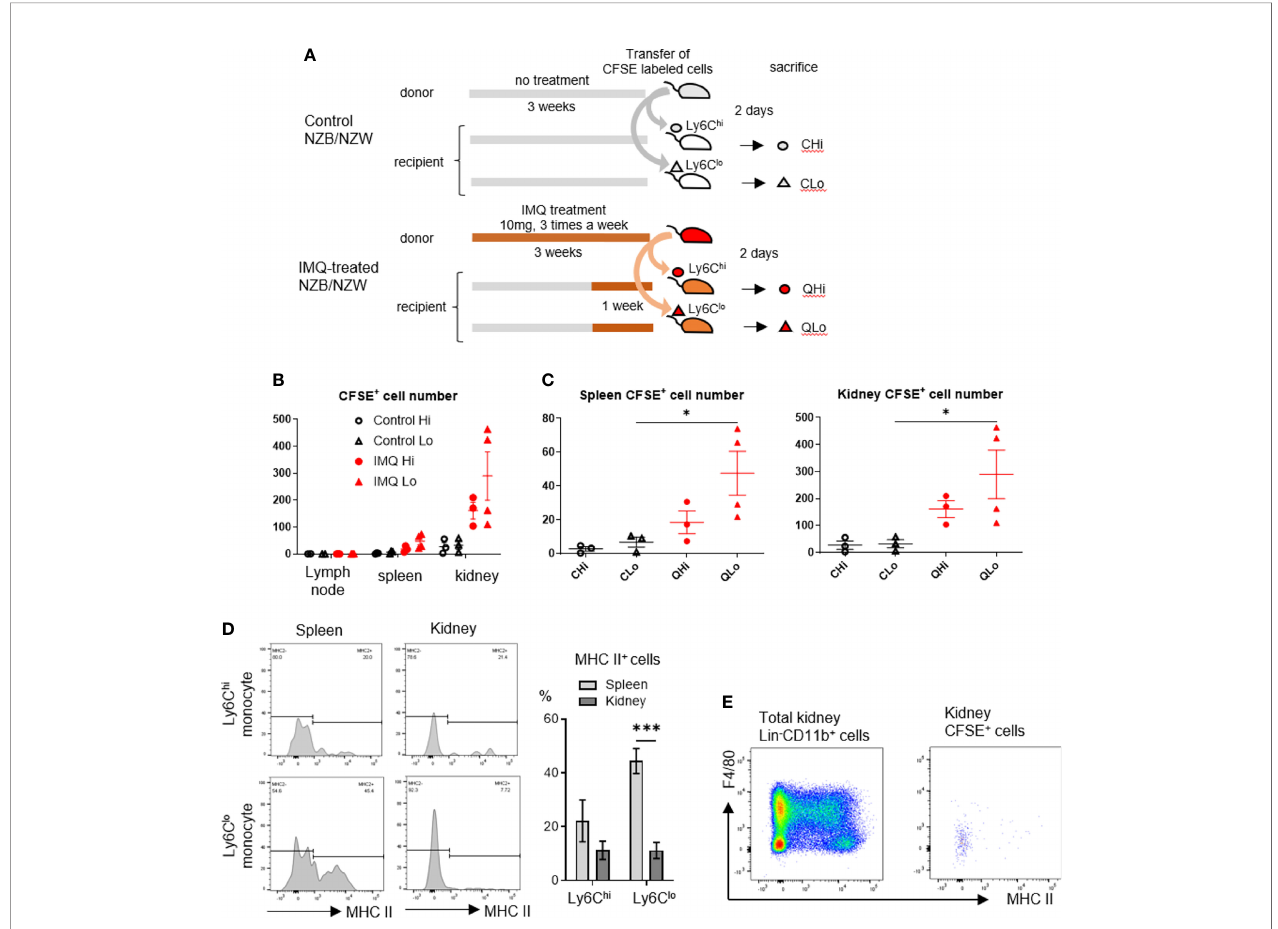
FIGURE 6 | Ly6C lo monocytes from IMQ-treated mice are more prone to in fi ltrate into tissues. (A) Sorted monocytes from control or IMQ-treated (10 mg, three times a week for 3 weeks) NZB/NZW mice were transferred to recipient control or IMQ-treated mice and tissues were analyzed 2 days after transfer. (B) Transferred CFSE labeled monocytes recovered from tissues were analyzed. (C) Transferred CFSE labeled monocytes recovered from spleens and kidneys were analyzed. (D) : CFSE + Ly6C lo monocytes recovered from spleens showed upregulated MHC class II whereas most transfused Ly6C lo monocytes in kidneys remained MHC class II negative. (E) Transferred Ly6C lo monocytes in kidneys maintained F4/80 - MHC II lo monocyte-like surface markers. In A and B, numbers of CFSE positive cells per 1×10 5 CD45 + cells are shown. Numbers were adjusted according to the transferred cell number that was normalized to 1×10 5 . (B – D) show the combined data of four experiments. Symbols represent individuals and horizontal lines indicate the mean and SEM. *P < 0.05 and ***P < 0.001 by one way ANOVA and post hoc Bonferroni ’ s Multiple Comparison